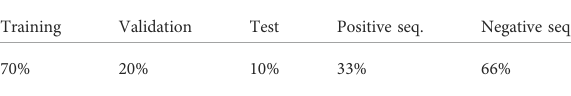
Table 1 The databases can be downloaded at https://github.com/